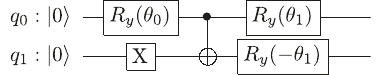
Fig. 2 Quantum circuit of singlet-restricted ansatz for two electrons in two-orbital system. X, R y , and the ⊕ connected to a dot represent the Pauli X-gate, Y-rotational gate, and CNOT gate, respectively. q 0 and q 1 are the labels for the two qubits and the order of tensor products shown in Eqs. (4) and (5) is q